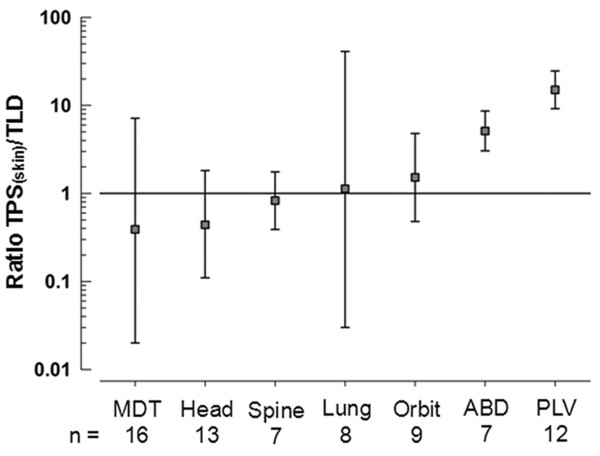
Limits of agreement for TPS[skin]/TLD ratios by anatomical site. 95 % limits of agreement for TPSskin/TLD ratios, by anatomical site. MDT, mediastinum; ABD, abdomen; PLV, pelvis.